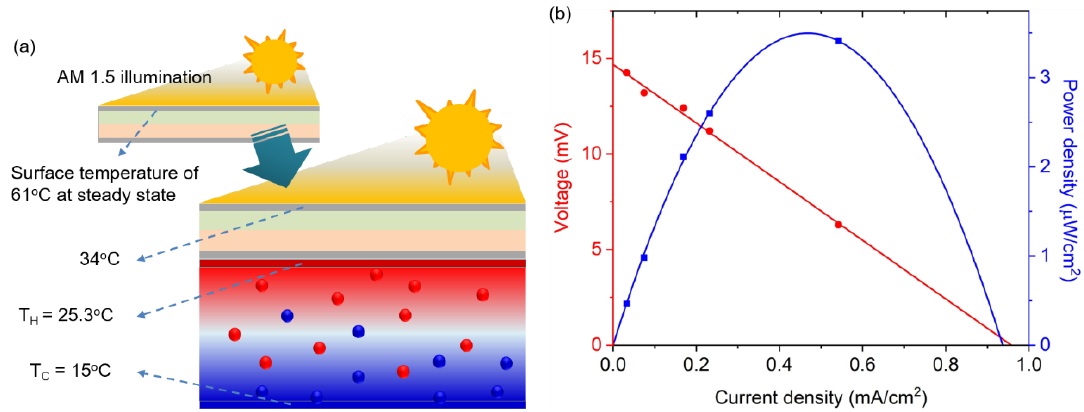
Figure 4. Feasibility test for the hybrid PV/T module: ( a ) temperature profile of the PV/T module under AM 1.5 G illumination; ( b ) J-V curve and the power generated by the thermocell.